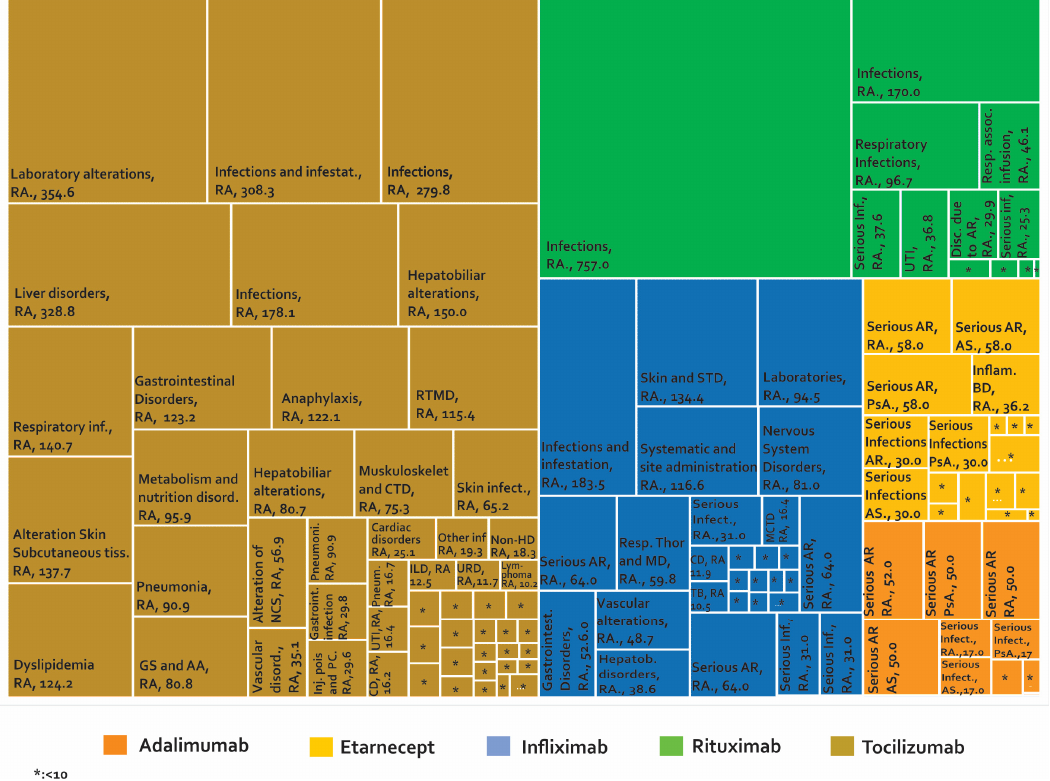
Figure 8. Adverse biotherapeutic events in rheumatic diseases presented in cases by 1000 patients/year [111,125,130–133,145–147,149,153–169]